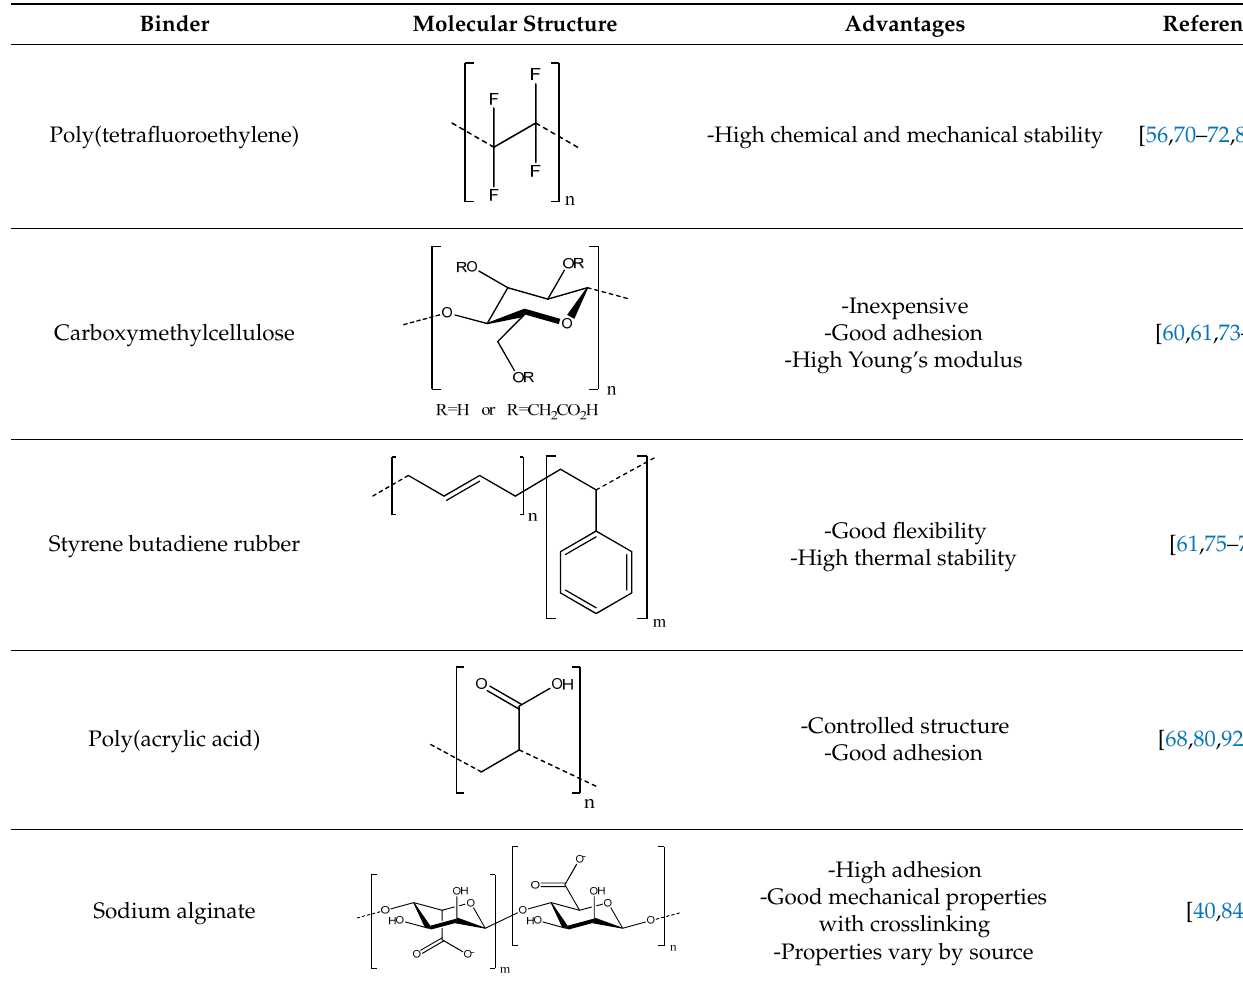
Table 2. Common polymer binders, their structures, and